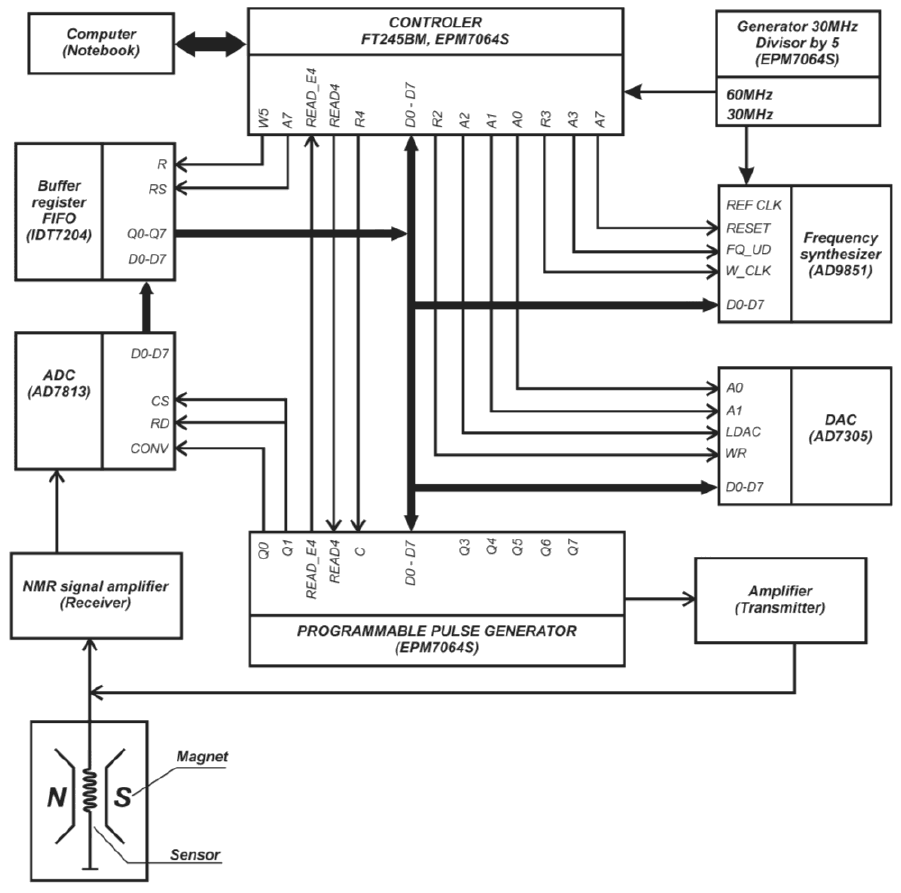
Figure 4. Principle electric scheme of Relaxometer PMR-NP.